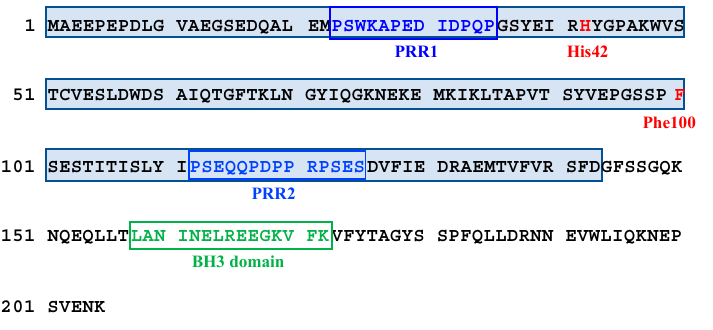
Figure 1. Amino acid sequences of mice SOUL. Blue letters: Pro-rich region 1 (PRR1) and Pro-rich region 2 (PRR2). Green letters: BH3 domain [9,10]. His42 is a heme-binding site [7]. Red F is Phe100. Pale blue shadow: the region of 1–143 amino acids.